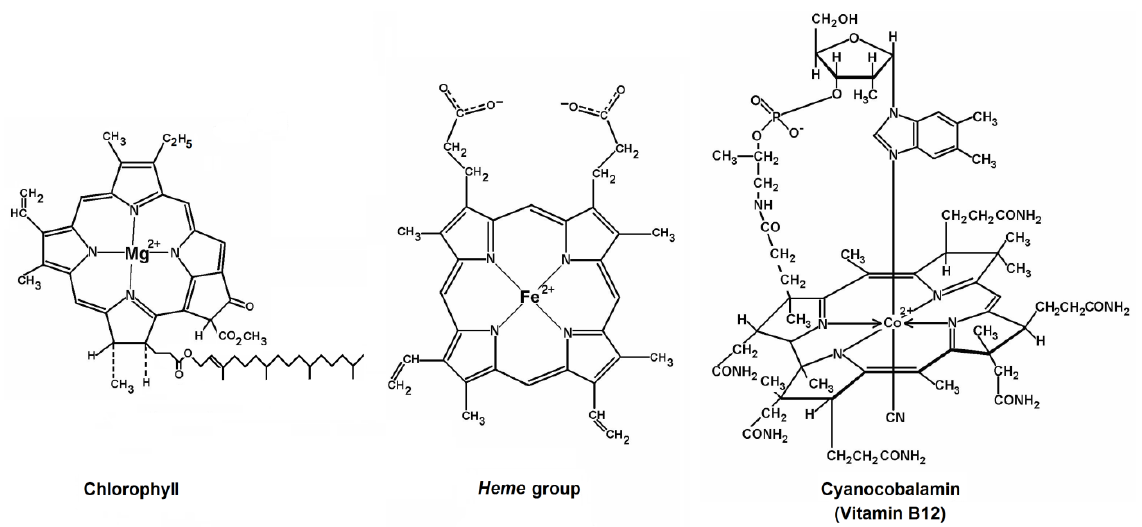
Figure 1. Porphyrinic structures are present in substances playing transcendental roles in life, such as chlorophyll , the heme group in blood and cytochromes, as well as in other substances as for instance